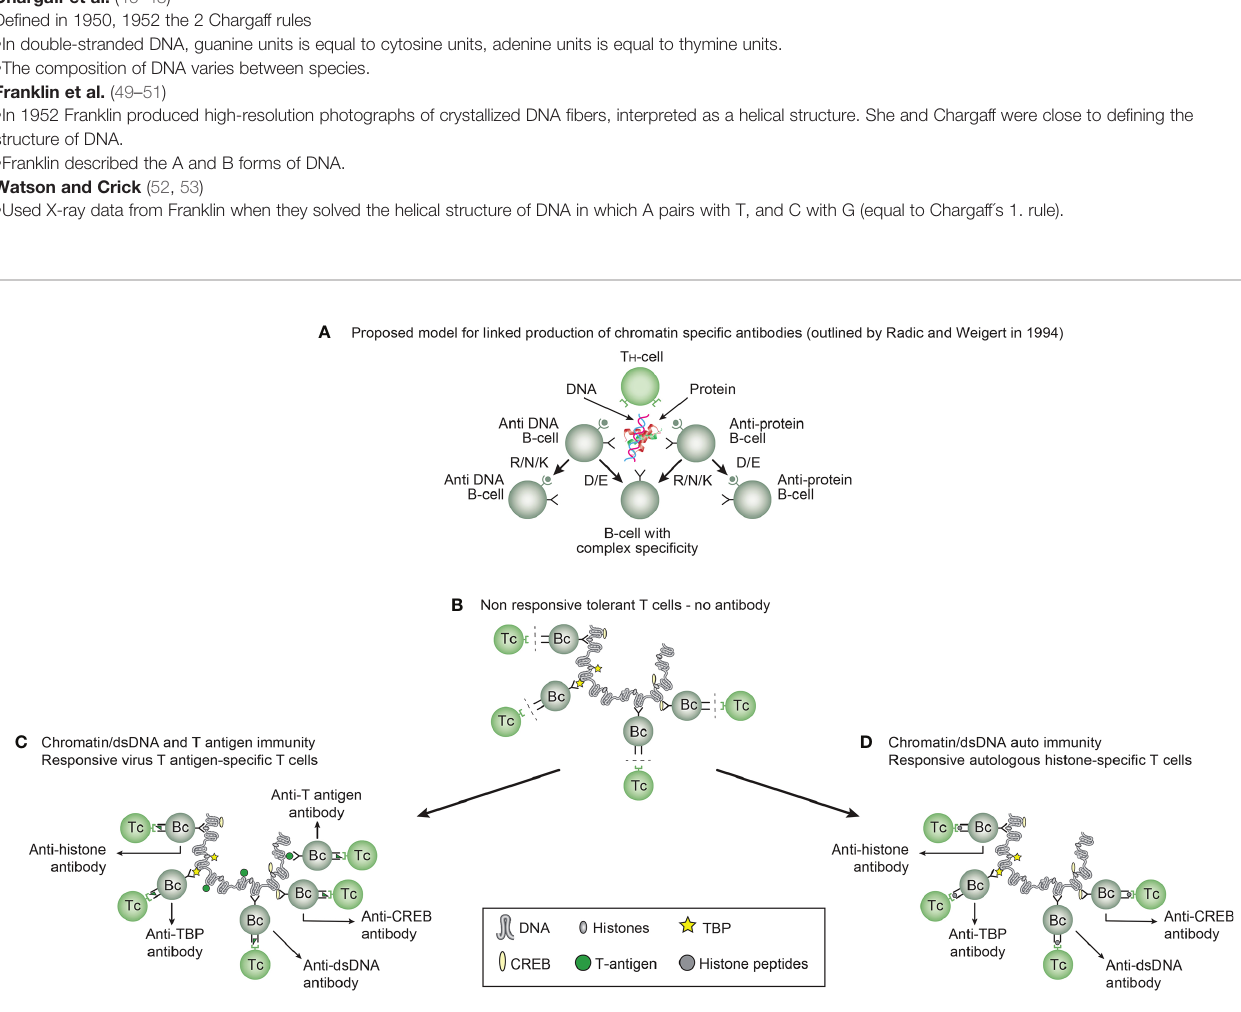
FIGURE 3 | Models for how production of anti-DNA antibodies may be initiated. In order to understand results of experimental and empirical studies aimed to describe origin of anti-dsDNA antibodies, we need to settle a semantic distinction: Anti-dsDNA antibodies may be the result of immune responses to DNA-protein complexes in two different contexts: immunity versus autoimmunity (A – D) . A utoimmunity signi fi es an autoimmune response promoted solely by autologous dsDNA in complex with chromatin-derived autologous proteins. Immunity implies immune responses to dsDNA/chromatin in complex with a non-self (like infection-derived) DNA-binding protein component. In general, antibodies to dsDNA generated in vivo is most probably a result of both categories of immunity. There are many reasons to argue for the validity of these models to generate anti-DNA antibodies. These arguments were basically presented as a theoretical model for the future by Radic and Weigert in 1994 [presented in (A) ]. In this model, aspects of af fi nity maturation is demonstrated as the B cell Ig variable regions are undergoing mutations to basic or acidic residues (This fi gure, Panel a, is re-drawn from a fi gure in reference (11), and provided by courtesy of Dr. Marko Radic, University of Tennessee Health Science Center). Deriving from this theoretical model, functional evidence-based models by Marion et al., Pisetsky, et al., and Rekvig et al. (32, 71 – 73) are demonstrated. In absence of responsive T cells a model for tolerance is presented (B) , and imply no help for DNA/chromatin-speci fi c B cells. The distinction between immunity and autoimmunity is demonstrated in Panels c an d, respectively. The principle difference relies on the speci fi city of the T cells. In immunity, the T cells are speci fi c for and engaged by non-self derived DNA-binding proteins (C) , while in autoimmunity, the T cells are engaged by autologous, chromatin-derived proteins like histones (D) . The basic model promoted by Radic and Weigert predicts a molecular and cellular prototype model also for linked production of antibodies to DNA, histones and other chromatin associated proteins, in accordance with theoretical re fl ections provided by Craft and Hardin already in 1987 (74). The repertoire of chromatin-speci fi c autoantibodies is from theoretic consideration the same for the models presented in (C, D) (see text for